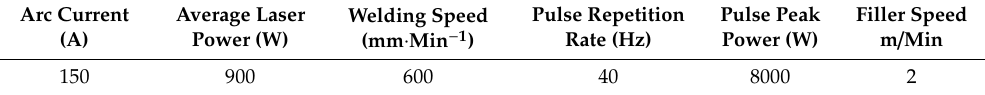
Table 5. Transverse tensile properties of laser–arc hybrid welded 6061-T6